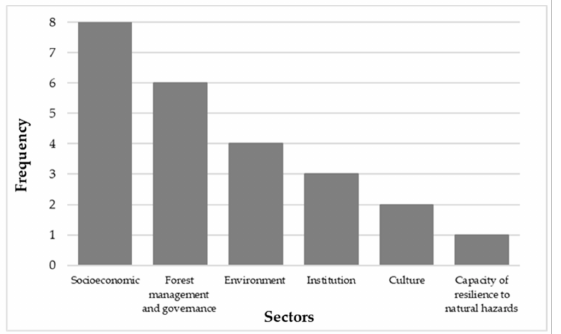
Figure 2. Sectors perceived to be affected by the PES project and their importance according to the quotes of the participants.